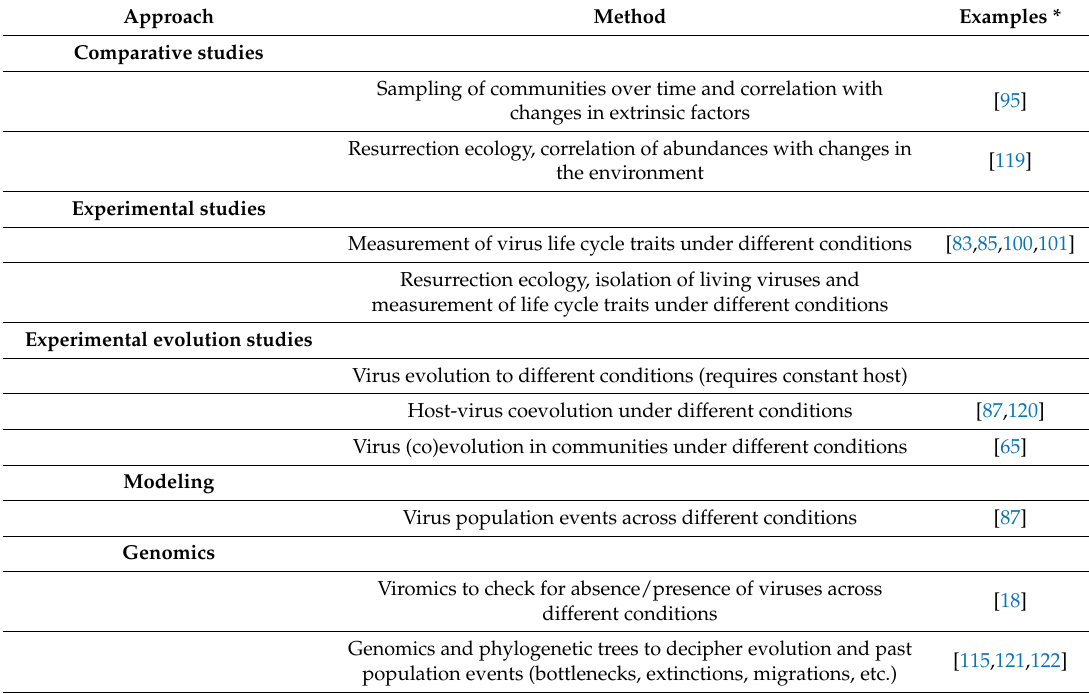
Table 1. Overview of approaches to study viral adaptations to conditions that make them unsuccessful. We refer to viruses as unsuccessful when (i) there are low numbers of viruses in the environment; (ii) they have low or no viral infectivity and/or (iii) they have low or no viral replication ability and subsequent low or no release of viral particles into the environment. All approaches can be carried out at temporal and spatial